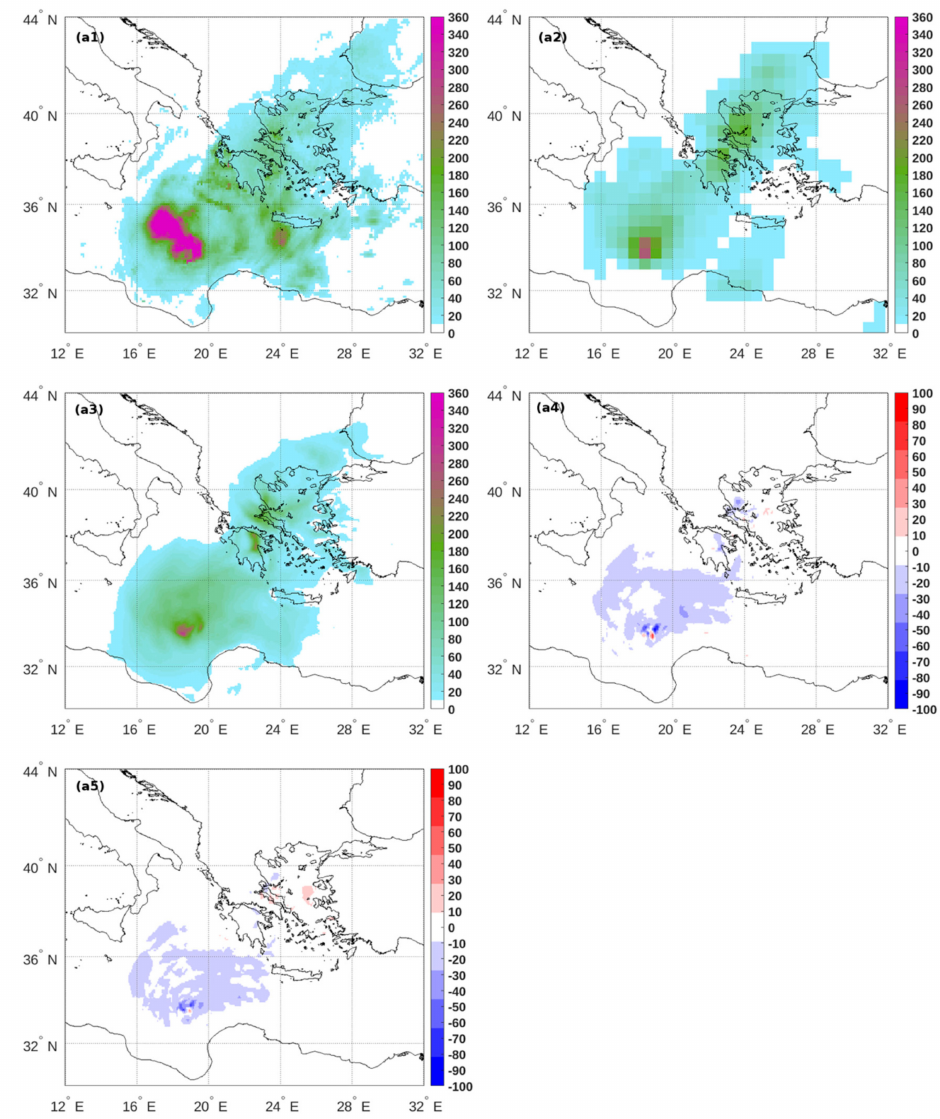
Figure 17. ( a1 ) Accumulated precipitation fields in millimeter from IMERG satellite data, ( a2 ) accumulated precipitation field in millimeters from MERRA-2 reanalysis, ( a3 ) accumulated precipitation field in millimeters from RTG-sst run ( a4 ) di ff erences in accumulated precipitation fields between NEMO-sst and RTG-sst, and ( a5 ) di ff erences in accumulated precipitation fields between OSTIA-sst and RTG-sst, for cyclone